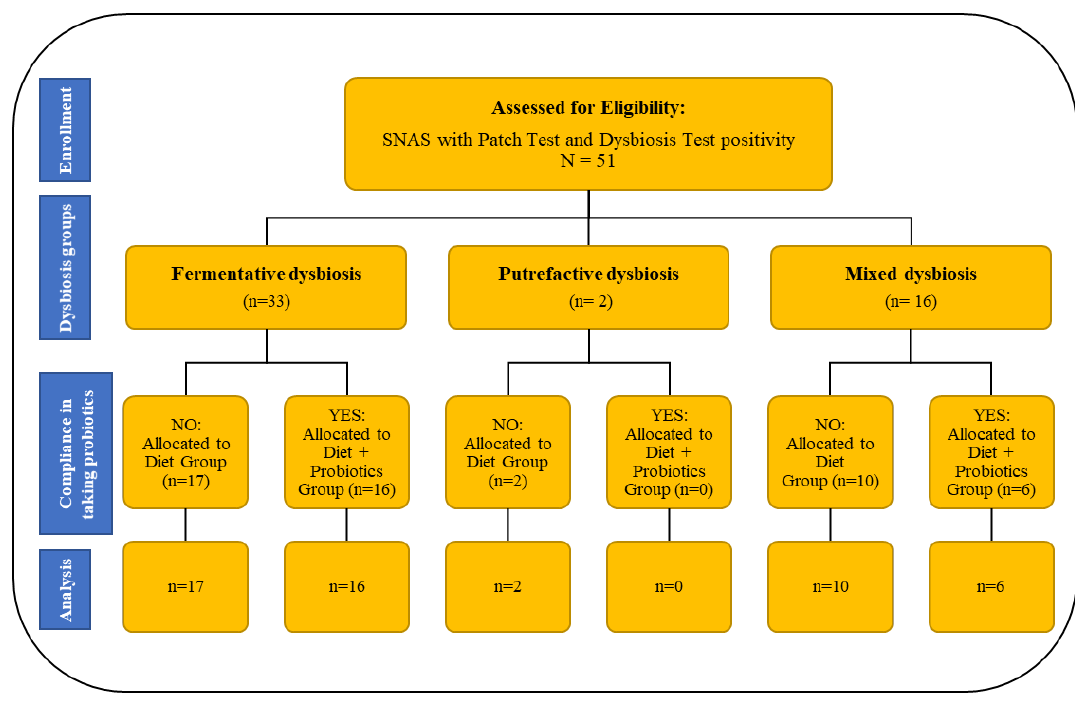
Figure 1. Summary of study design and patient flow diagram